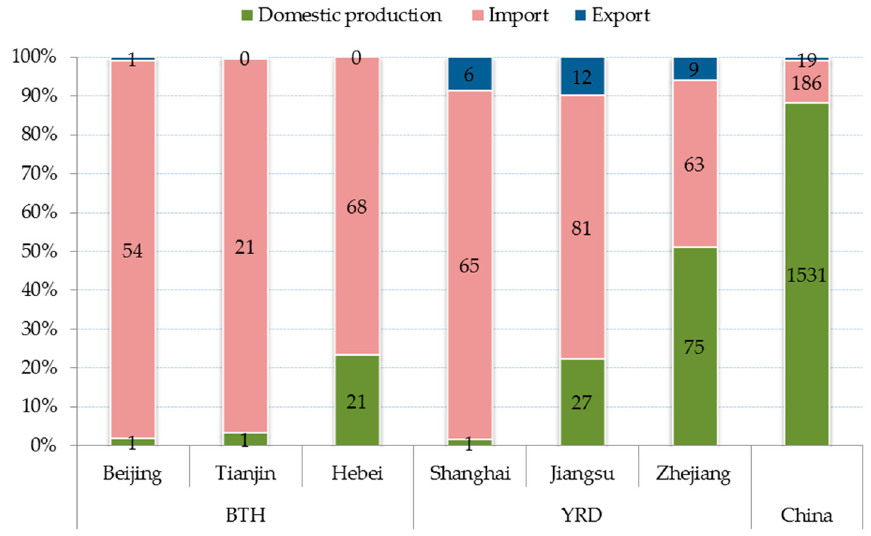
Figure A5. Power exchange (TWh/yr) of study regions and China in 2015 (data source: China Energy Statistical Yearbook 2016 [17]).